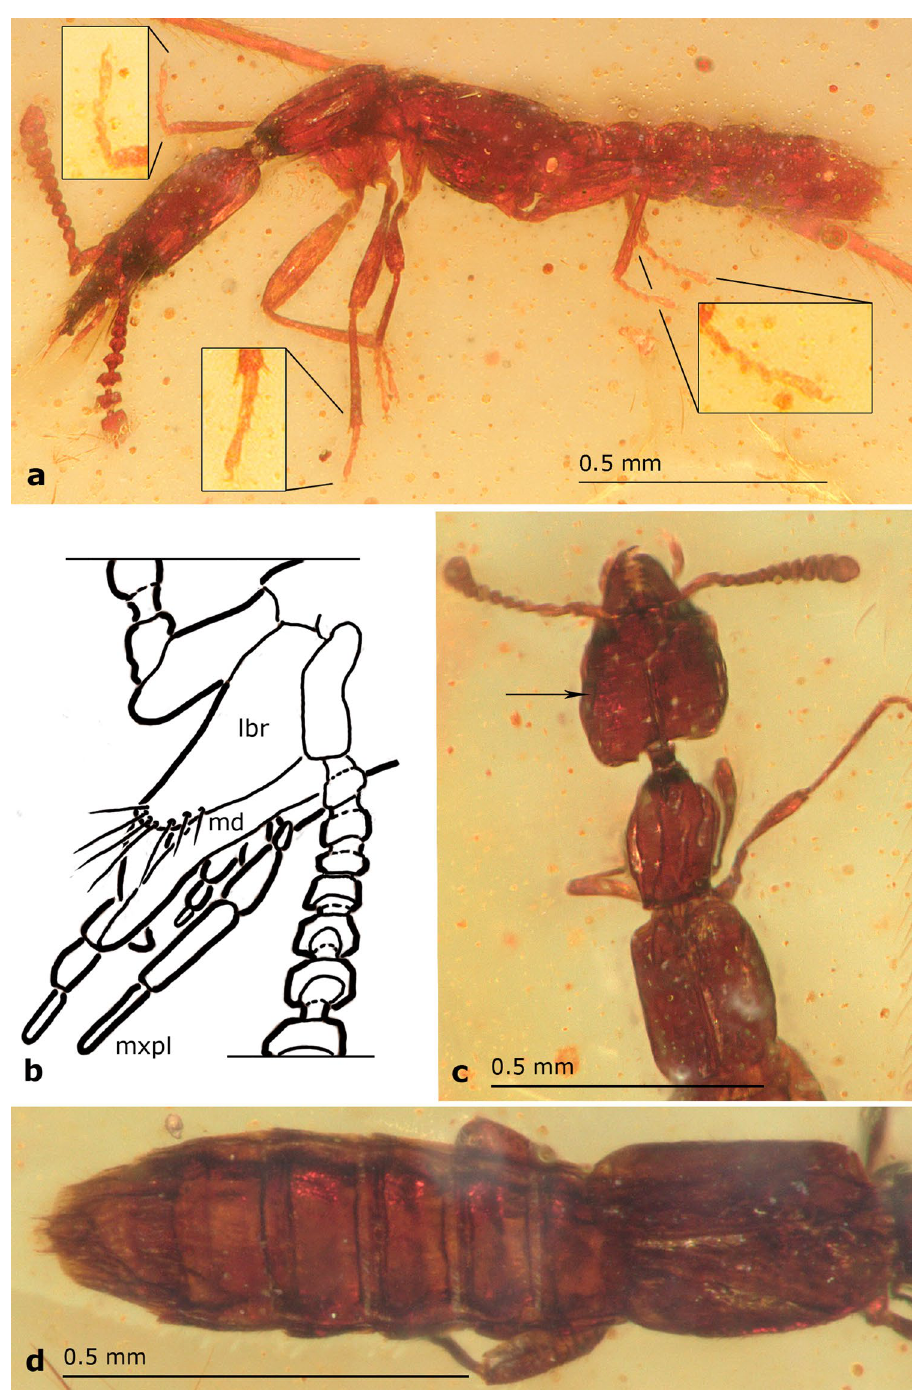
Figure 4. Midinudon juvenis gen. and sp. nov., paratype, collection number GPIH05516. (a) Photo of habitus, lateral view. Close-ups of tarsi in frames. (b) Drawing of head and mouthparts: lbr – labrum, md – mandibula, mxlp – maxillary palpus. (c) Photo of forebody, dorsal view. Ridge separating flat area above and behind eye marked with an arrow. (d) Photo of meso-, metathorax, and abdomen, dorsal